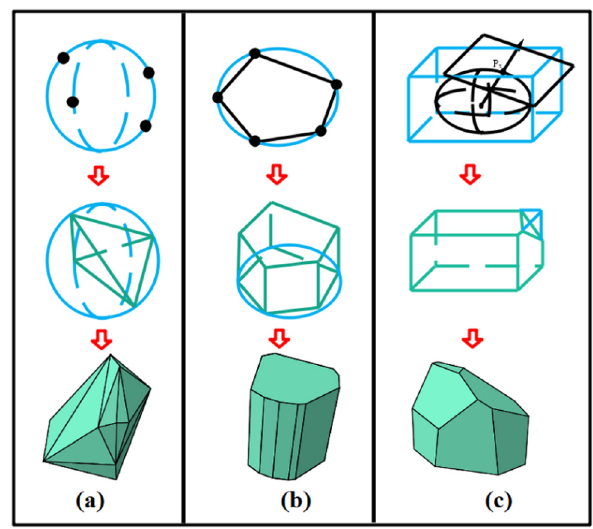
Figure 3: Schematic diagram of particle modeling: ( a ) DTM, ( b ) PEM, and ( c )